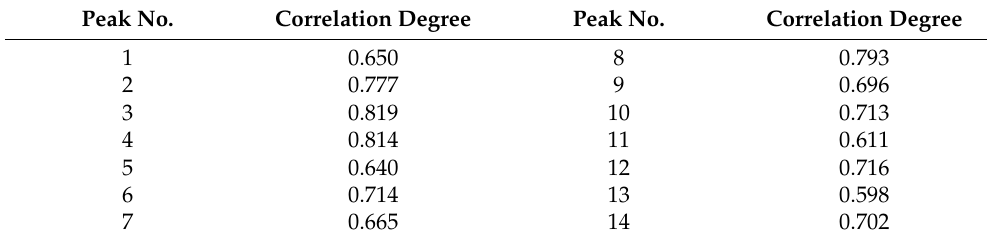
Table 3. The correlation degree of partial acid hydrolysates. Peak No. Correlation Degree Peak No. Correlation Degree 1 0.650 8 0.793 2 0.777 0.696 0.819